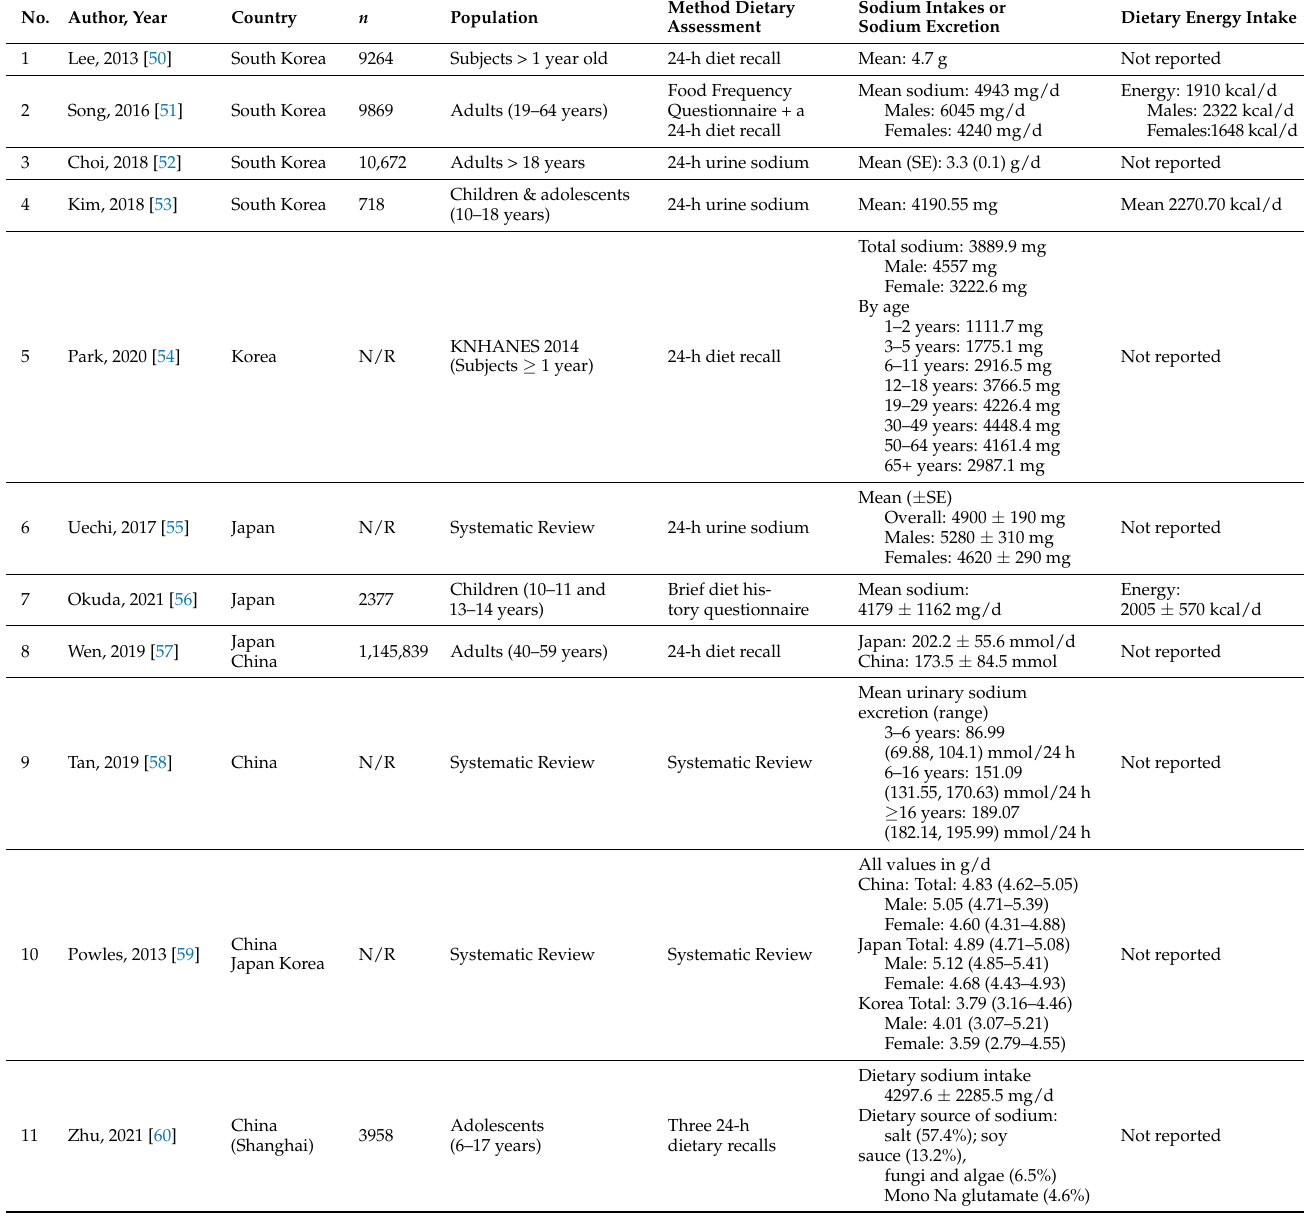
Table 1. Dietary sodium consumption in Asian